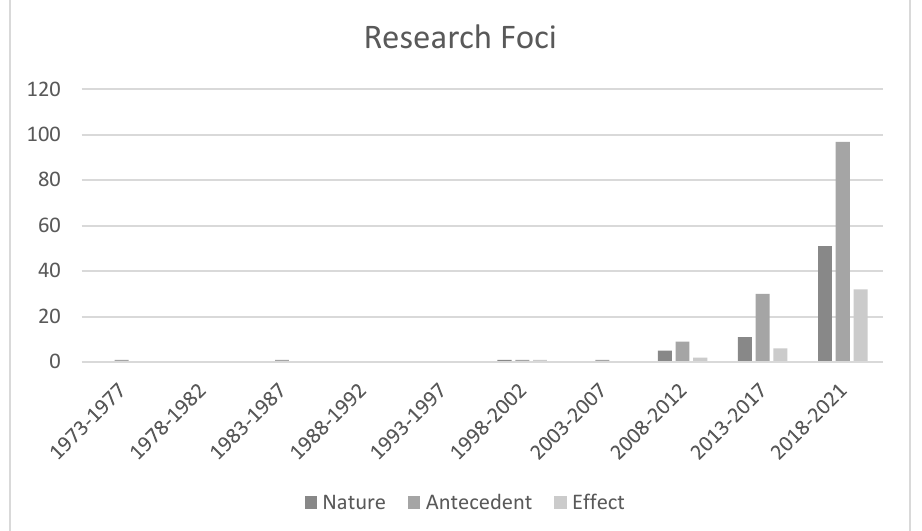
Figure 3. Trend of Research Foci by Five-Year Interval during 1973 – 2021 (n = 168).